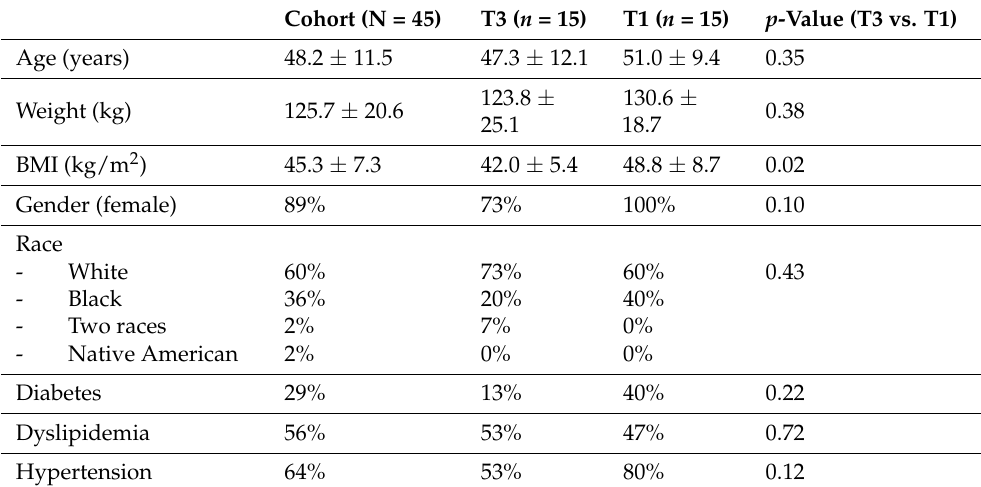
Table 1. Baseline demographics, anthropometric measures, and comorbidities, with comparison of the highest %TWL tertile (T3) with the lowest %TWL tertile (T1). Cohort (N = 45) T3 ( n = 15) T1 ( n = 15) p -Value (T3 vs.